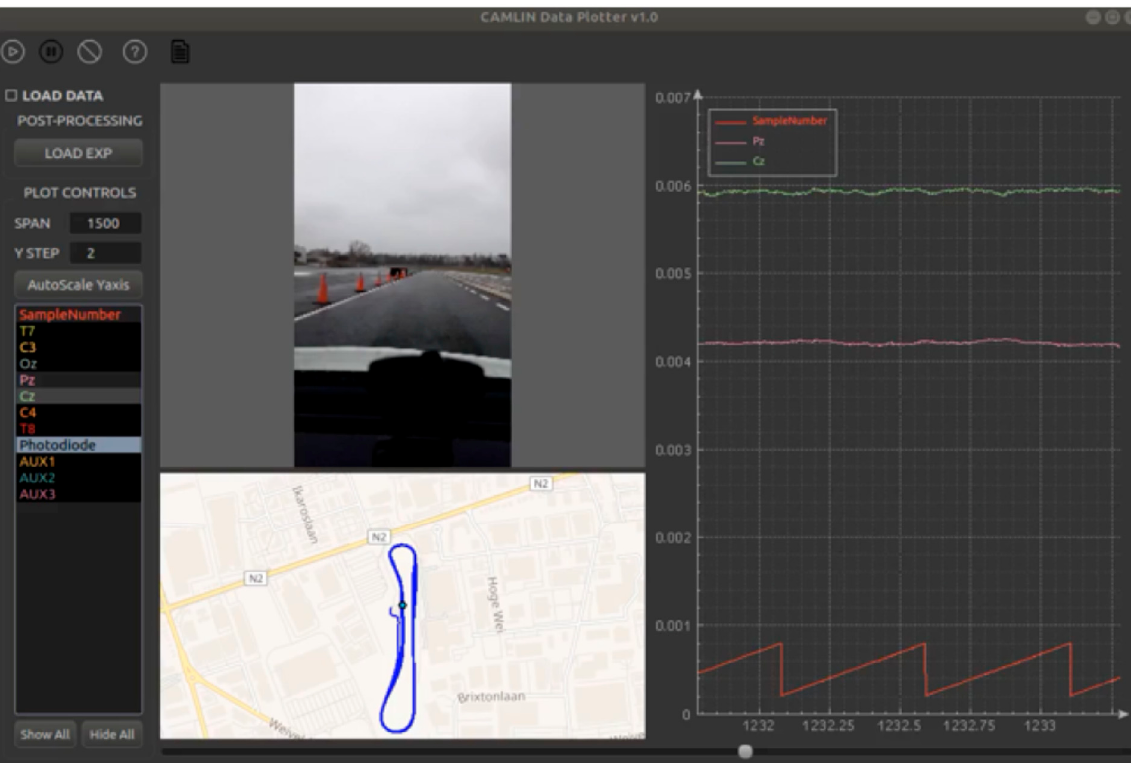
Figure 1. Multimodal GUI. A screenshot of the GUI while using the Biohub in a car experiment is shown. On the left, the user can use the menu to start the recording, load pre-recorded datasets, or control plot parameters and data sources. The central panel shows the synchronized video captured from the smartphone camera pointing at the road and the route reconstructed by the GPS module of the Android smartphone. On the right, two EEG signals and one control signal are plotted according to the selection carried out by the user.